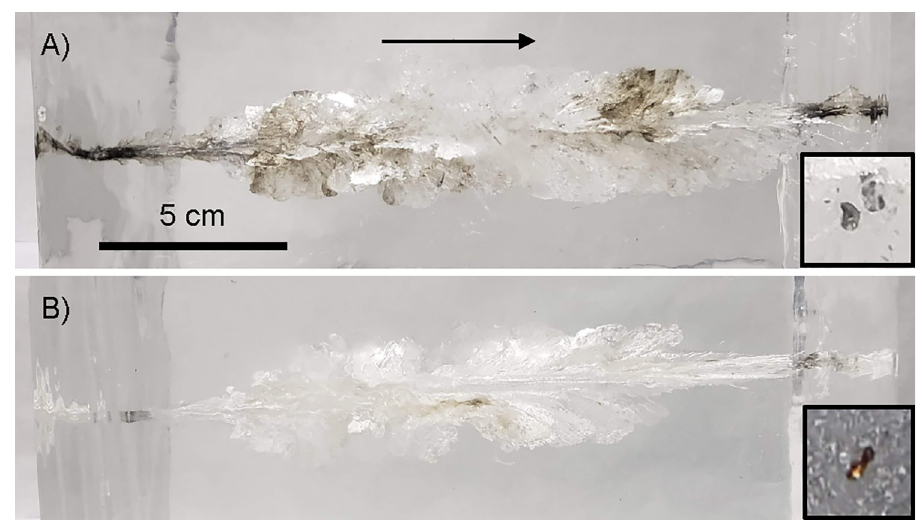
Fig 1. Photographs of ballistic gelatin block samples. The bullet trajectory is indicated by the arrow, and both images are on the same spatial scale. The insets at right are examples of embedded bullet fragments clearly visible within the samples. (A) Lead-core bullet without bone. (B) Copper bullet without